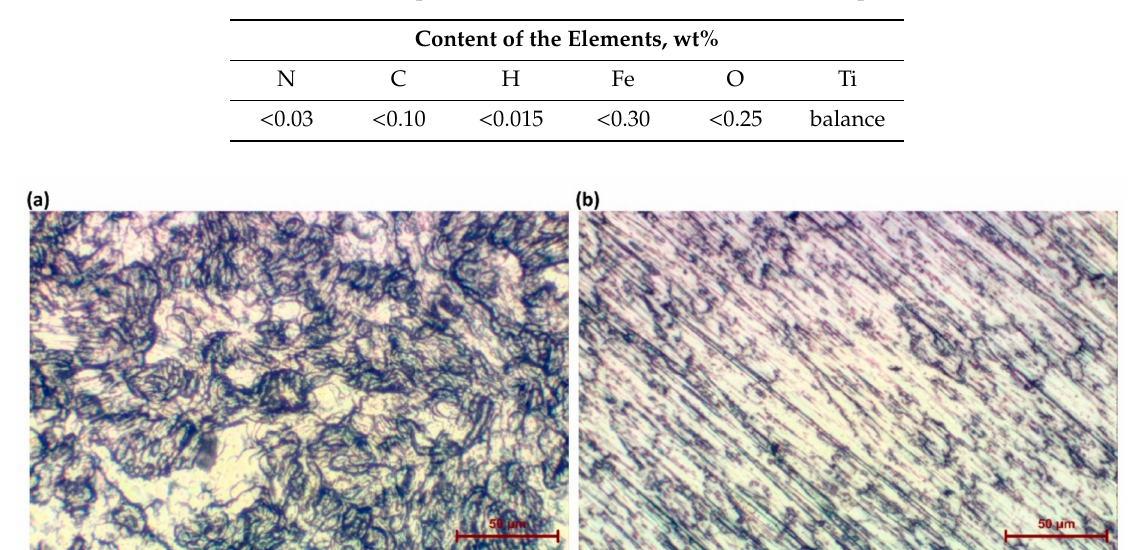
Table 1. Chemical composition of Titanium Grade 2 (anode in PEO process).